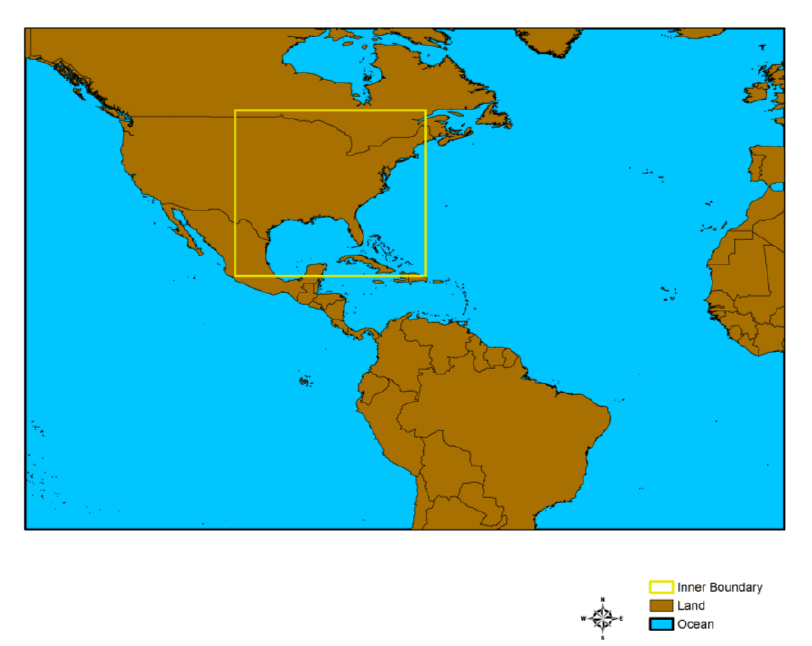
Figure 2 . Model domains—outer domain (27 km) and inner domain (9 km).